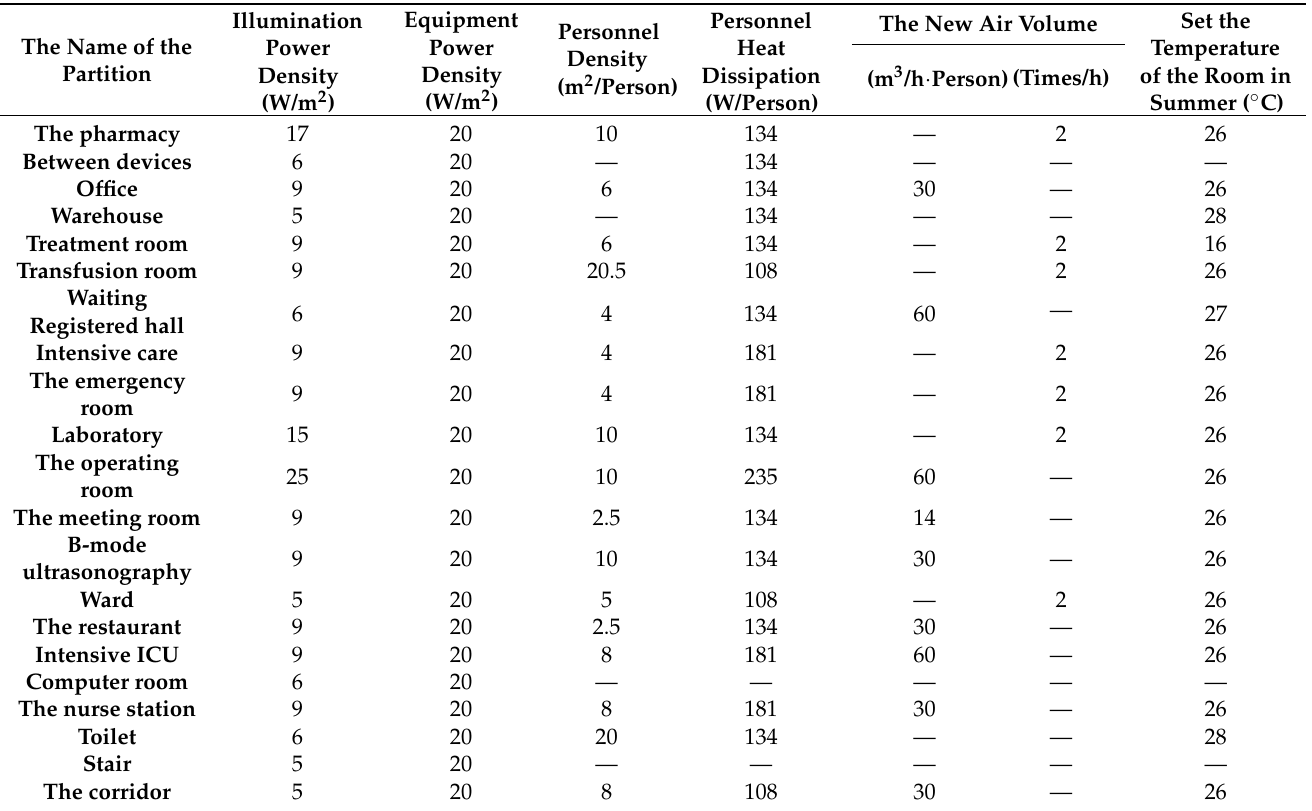
Table 19. Room partitioning parameters for healthcare